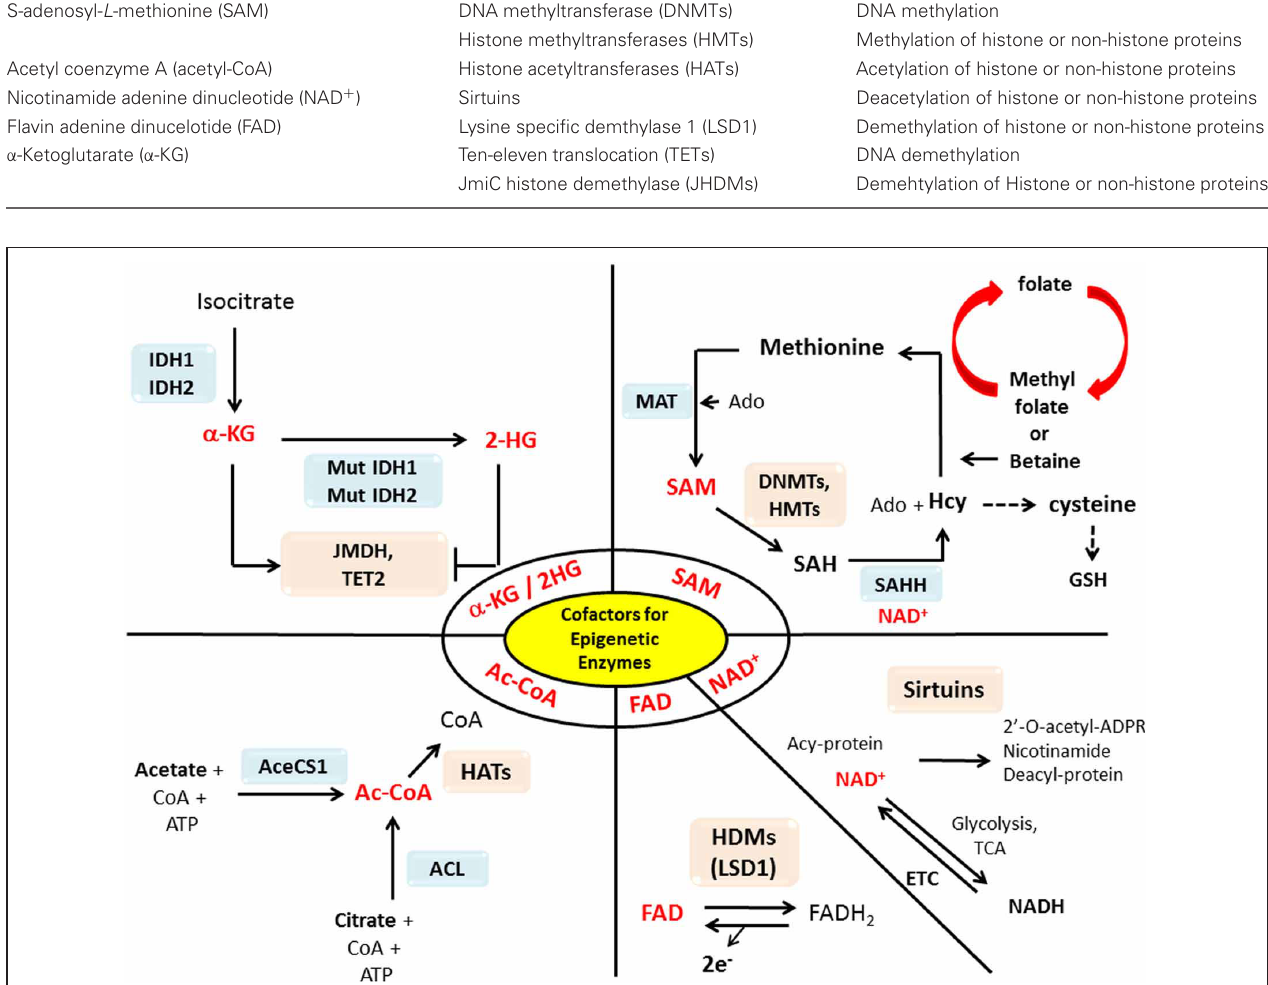
FIGURE 1 | Interactions between metabolism and epigenetics. Metabolites that are used as substrates and cofactors for reactions that coordinate epigenetic status (red colors) are centered in this diagram, with the corresponding enzymes that utilize them shown with their chemical reactions. Abbreviation used in this figure: AceCS1, Acetyl-CoA synthetase 1; ACL, ATP-citrate lysase; Ac-CoA, Acetyl-CoA; Acy-protein, Acetylated-protein; Ado, Adenosine; α -KG, α -ketoglutarate; CoA, Co-enzyme; DNMT, DNA methyltransferase; ETC, Electron transport